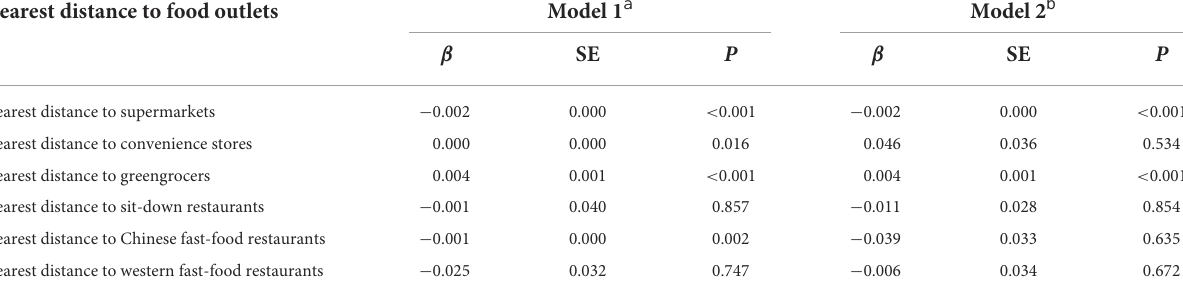
TABLE 6 Associations between proximity to food outlets and